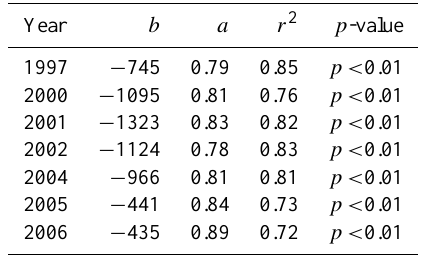
Table 1. The closure of the surface energy balance was calculated by comparing daily total fluxes of net radiation (Wm − 2 ) against the sums of sensible heat flux (Wm − 2 ), latent heat flux (Wm − 2 ), soil heat flux (Wm − 2 ) and heat storage (Wm − 2 ). In all cases the model used was: y ( x )= a * x + b . Included in the table are estimates of the coefficient of determination ( r 2 ) and the p -values for each regression analysis.